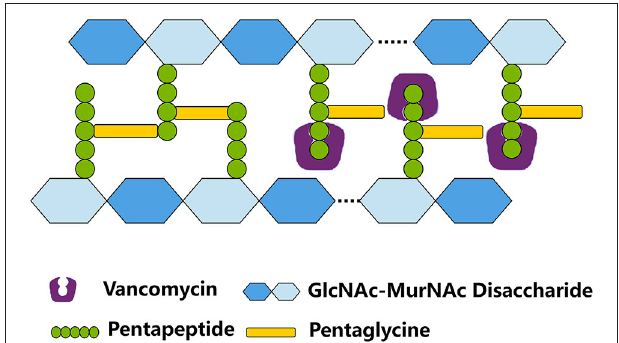
FIGURE 1 | The mode of action of vancomycin in S. aureus . By binding to the C-teminal D-Ala-D-Ala residues of the pentapeptide, vancomycin inhibits the cross bridge formation between pentapeptide and pentaglycine. GlcNAc, N-acetylglucosamine; MurNAc, N-Acetylmuramic acid.